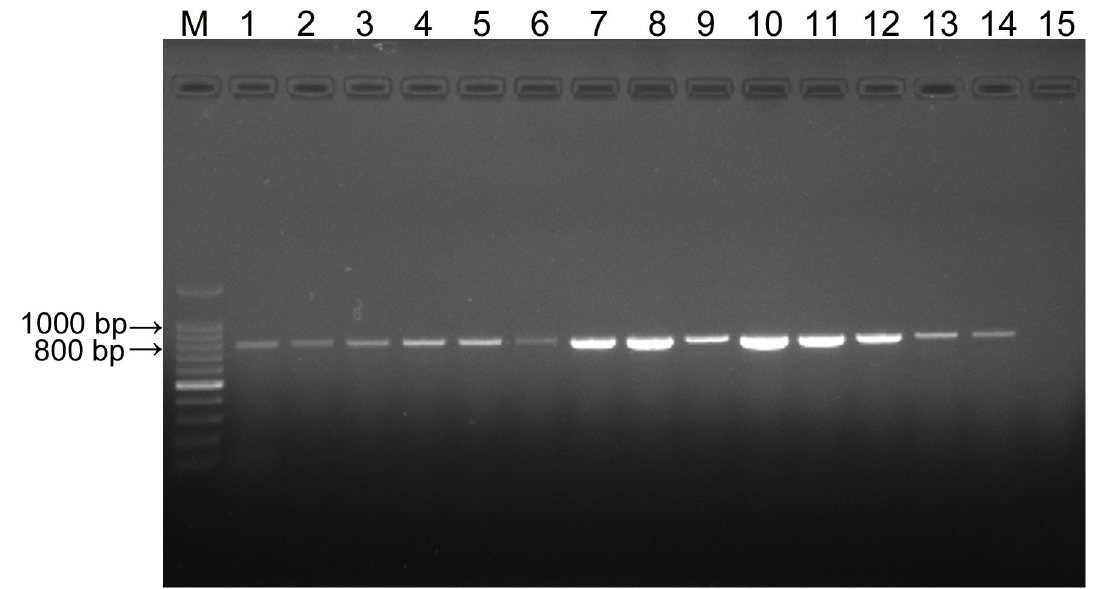
Fig 1. PCR amplification results for the DHPS gene. M: 100 bp DNA marker; Lanes 1–14: DHPS gene amplification product of PCP patients; Lane15: negative control.